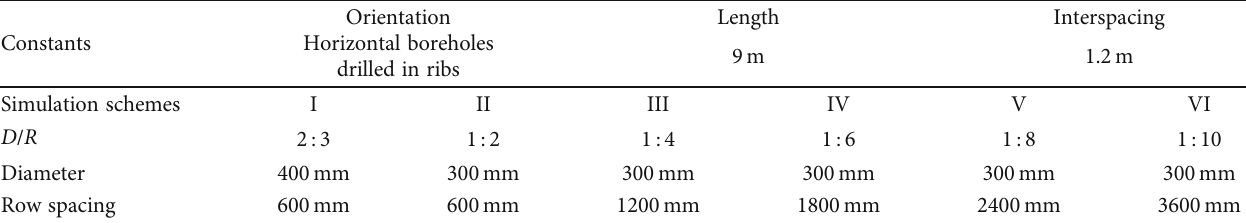
Note that the simulation results without boreholes were regarded as a reference for